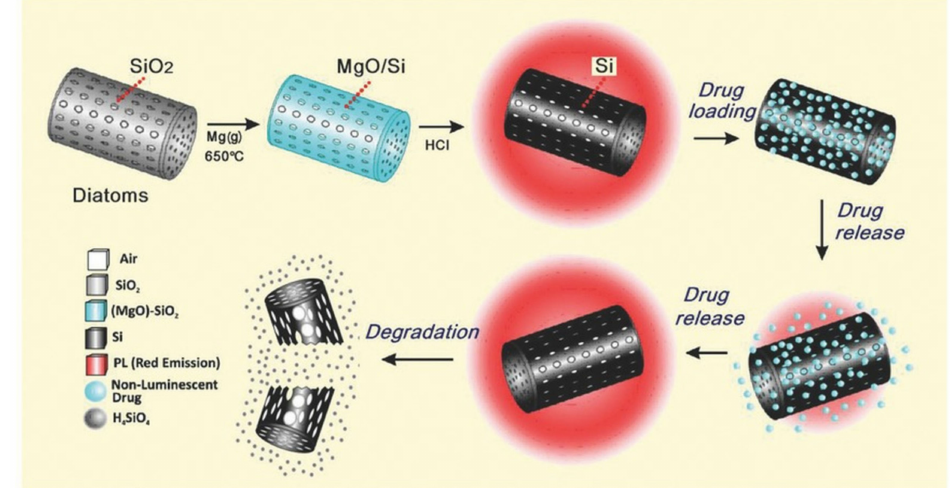
Figure 14. Schematic illustration of the gas / silica displacement method on the basis of the magnesiothermic reduction process employed to convert silica diatoms’ 3D structure into luminescent silicon replicas as a new biodegradable microcarrier with self-reporting function and a unique biological-derived shape that is desirable for high drug loading and sustainable release for broad drug delivery applications. Reproduced from [55], copyright (2015), with permission from John Wiley and